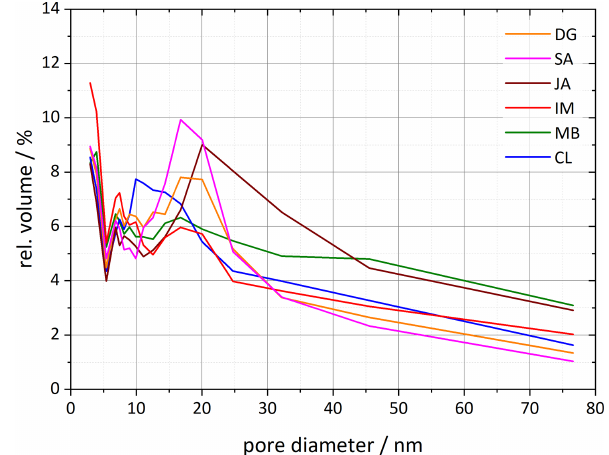
Figure 7. Pore size distributions for each of the six halloysite sam- ples resulting from DVS isotherms analyzed between 35% and 98% RH. Plotted is the relative pore volume against the pore di- ameter (calculated using Eq. 1 in Sect. 3.3). Dust sample codes are identical to those in Fig.